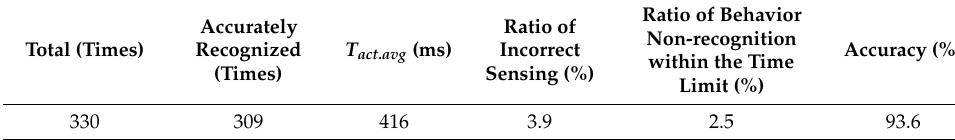
Table 2. Comprehensive cognitive performance results for all unit-behaviors.